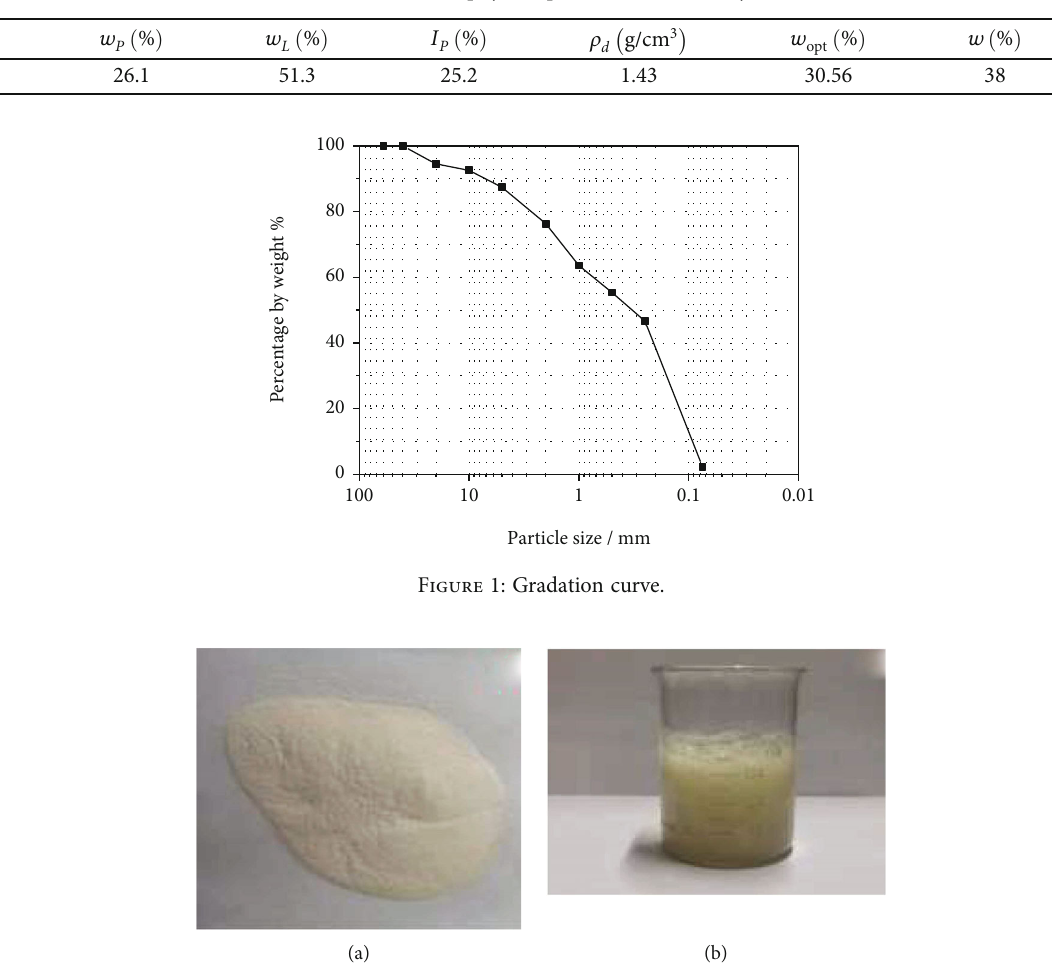
Table 1: Basic physical parameters of red clay.